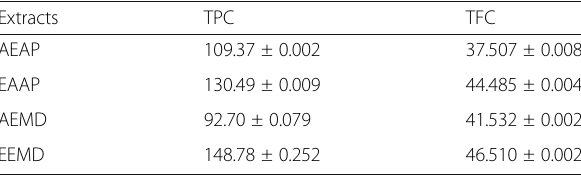
Table 2 Total phenolic and flavonoid content of the prepared plant leaf